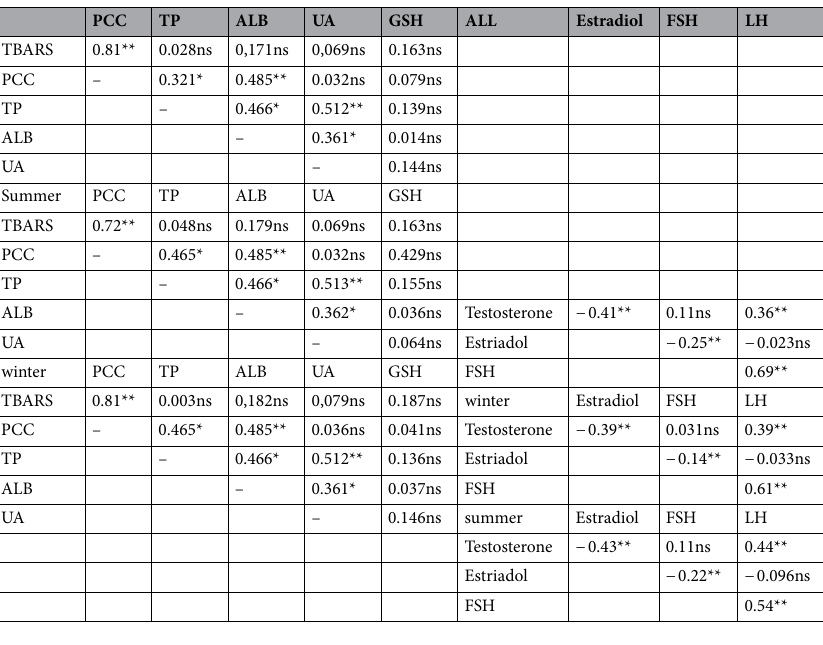
Table 7. Correlations between the season and bulls’ blood parameters. Explanation: ** P ≤ 0.01; * P ≤ 0.05; ns = P > 0.05.